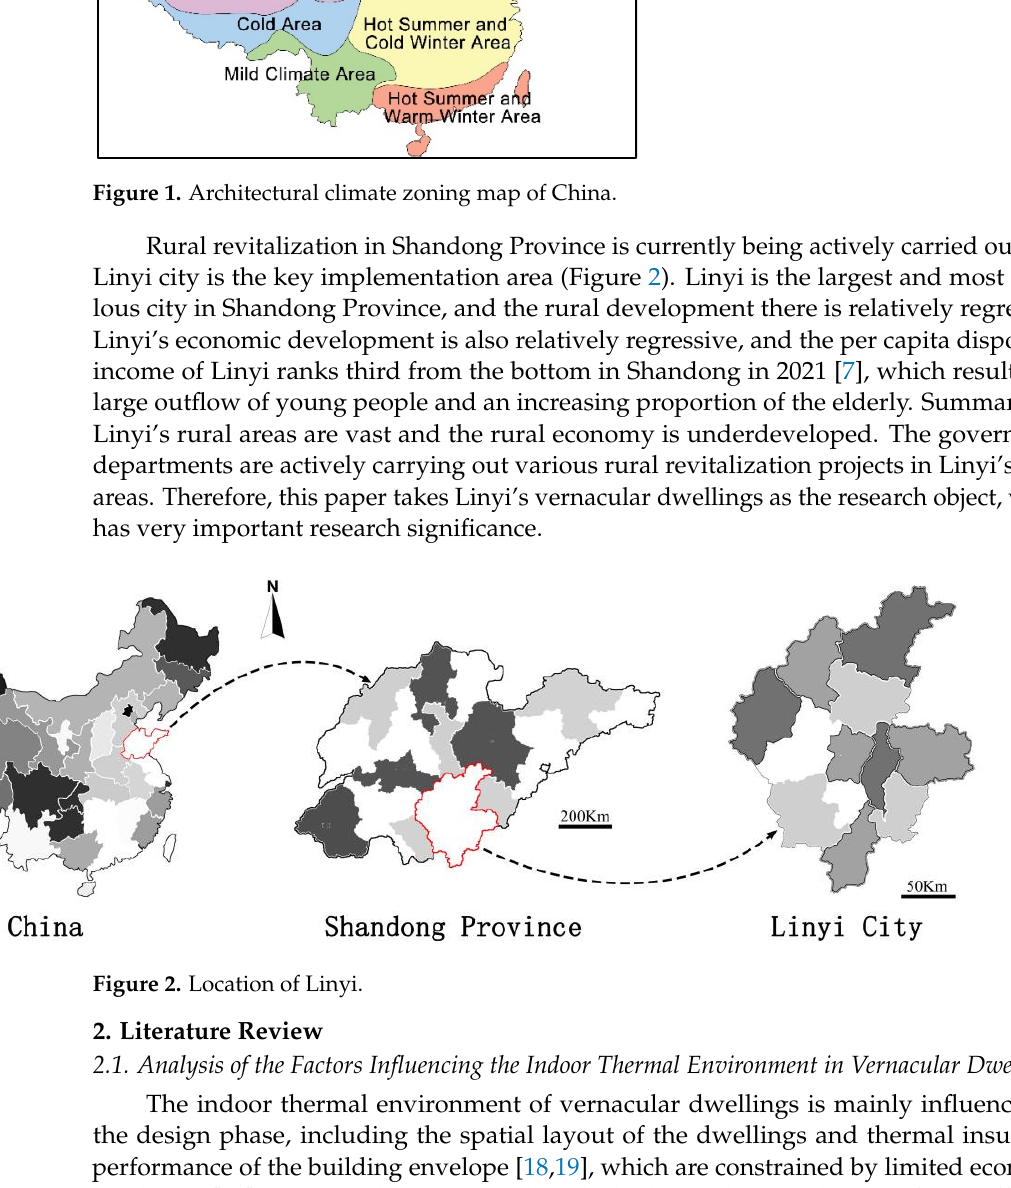
Figure 1. Architectural climate zoning map of China.